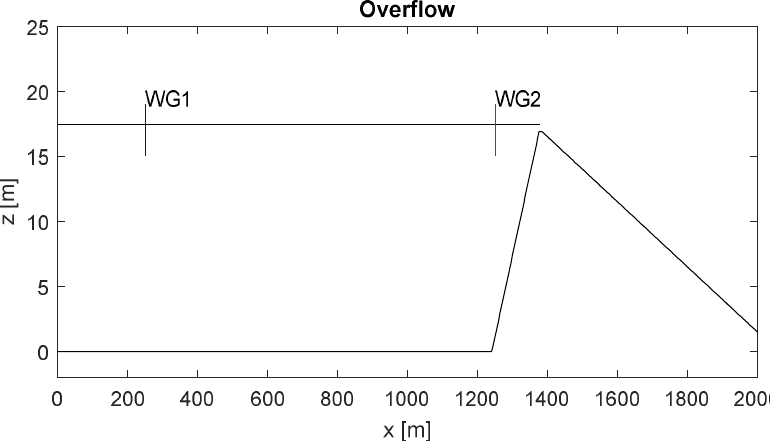
Figure 4. Cross ‐ sectional view of the SWASH model domain setting applied to the overflow simu ‐ lation (the straight line represents the initial water level).